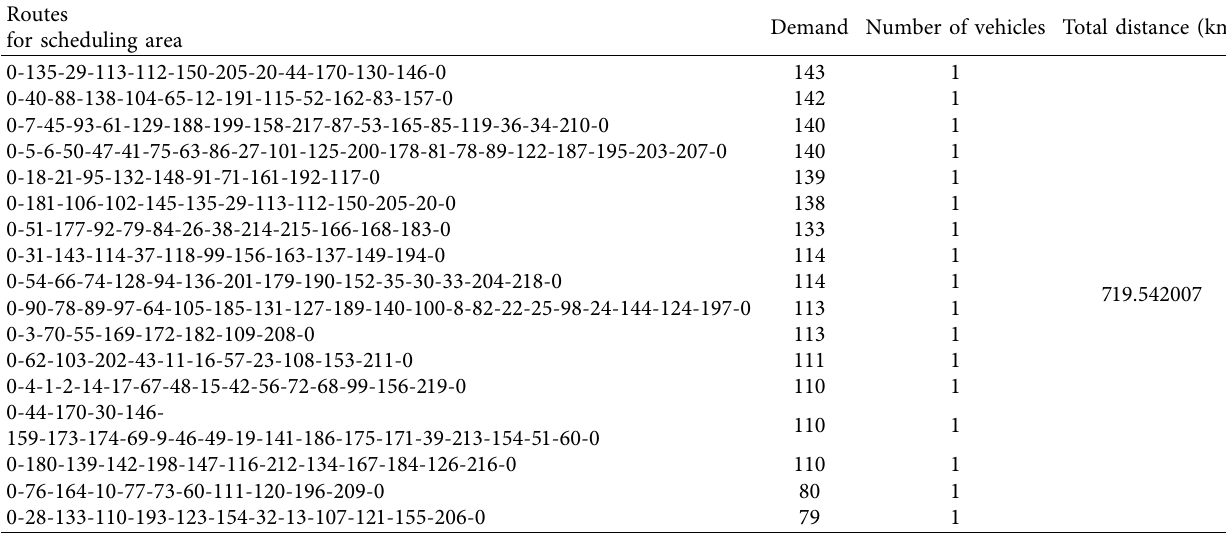
Table 4: Te optimal routes for scheduling areas in the morning peak. Routes